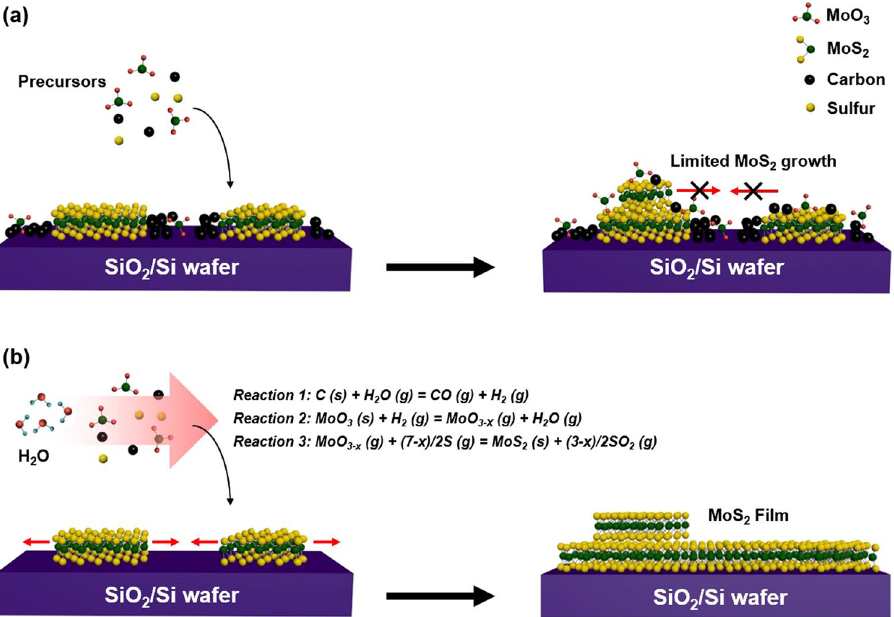
Figure 5. Different growth behavior. ( a , b ) Schematic illustration of MoS 2 growth ( a ) without and ( b ) with water supply. Without water supply, unwanted impurities such as MoO 3 and a-Cs inhibit the completed MoS 2 film. In the presence of water, the full-covered MoS 2 film is grown through Reactions